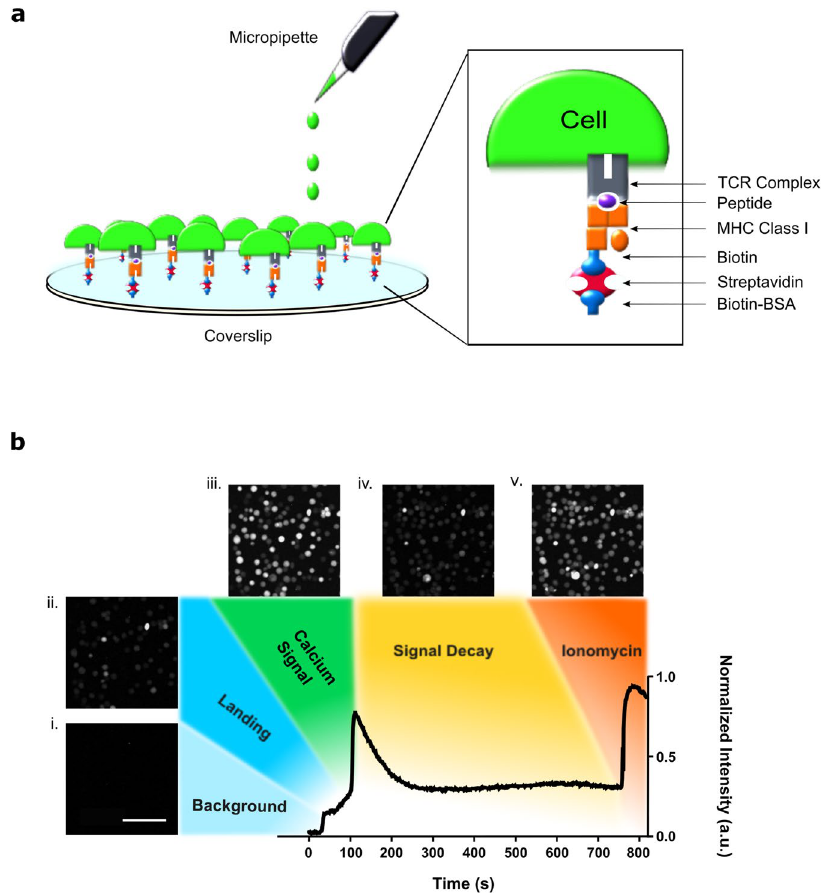
Figure 1. Model of T cell response on antigen functionalized coverslips. ( a ) Diagram of antigen functionalization onto glass coverslips with pMHCs. ( b ) Representative normalized Ca 2 + based fluorescence intensity plot of a Jurkat T-cell upon landing on a 4D:MHC I functionalized coverslip with a subset of cells from one movie shown in the images taken at (i) 0 s, (ii) 38 s, (iii) 117 s, (iv) 514 s, (v) 764 s. Each circular white circular dot represents 1 cell. Scale bar is 100 µ